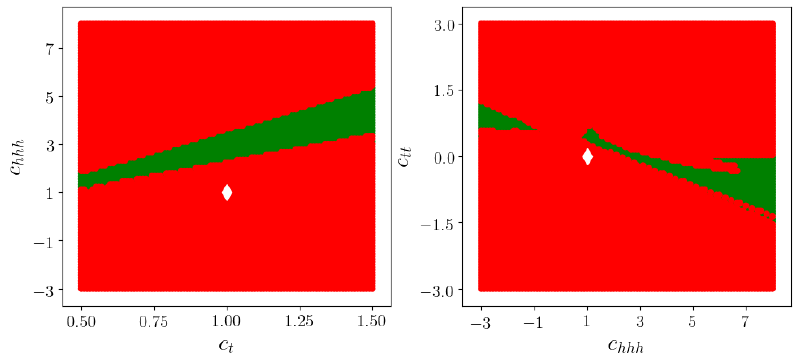
Figure 8 . The parameter space associated to each shape type in the c t (cid:0) c hhh and c hhh (cid:0) c tt planes for the p T;h